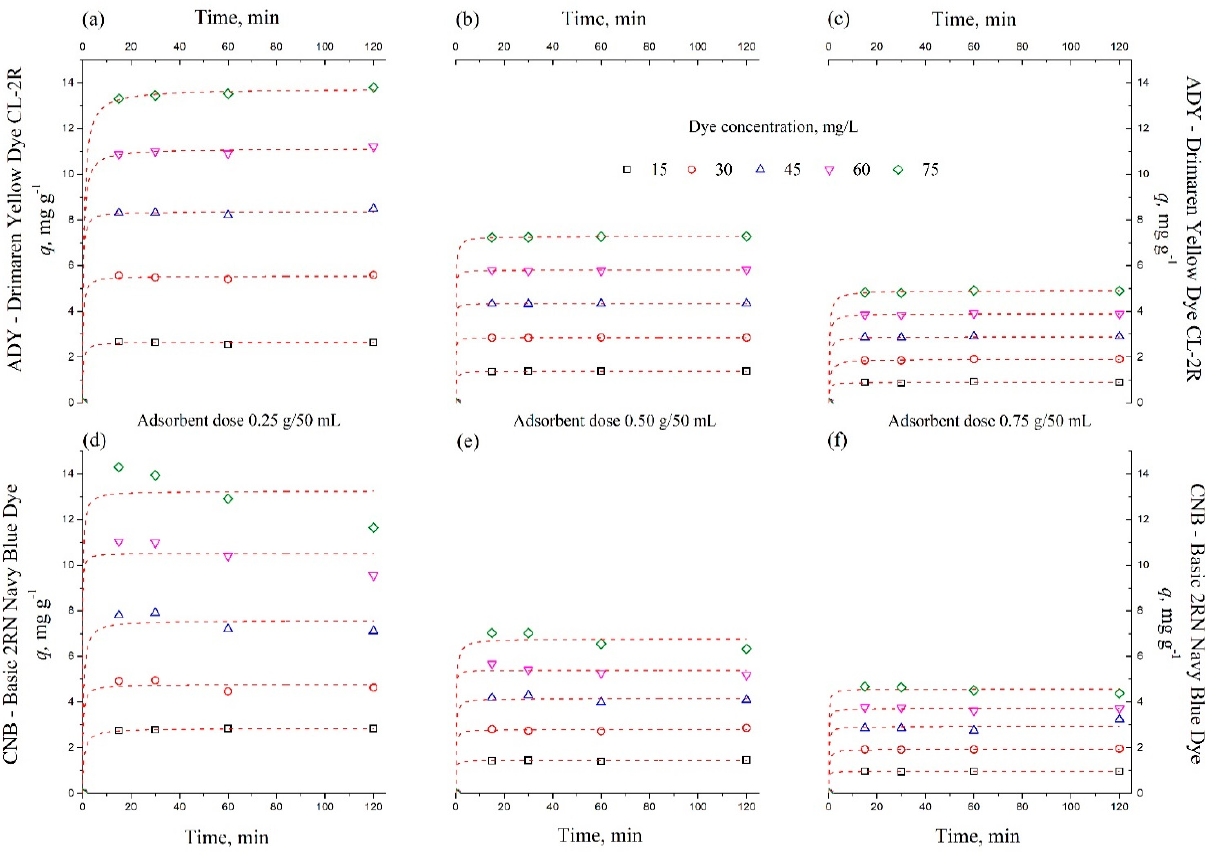
Figure 10. Adsorption kinetic profiles of ADY ( a – c ) and CNB ( d – f ) dyes onto RC particles at different initial adsorbent dosages and dye concentrations; T = 20 °C. The dashed lines are the theoretical data predicted by the PSOM, Equation (13).